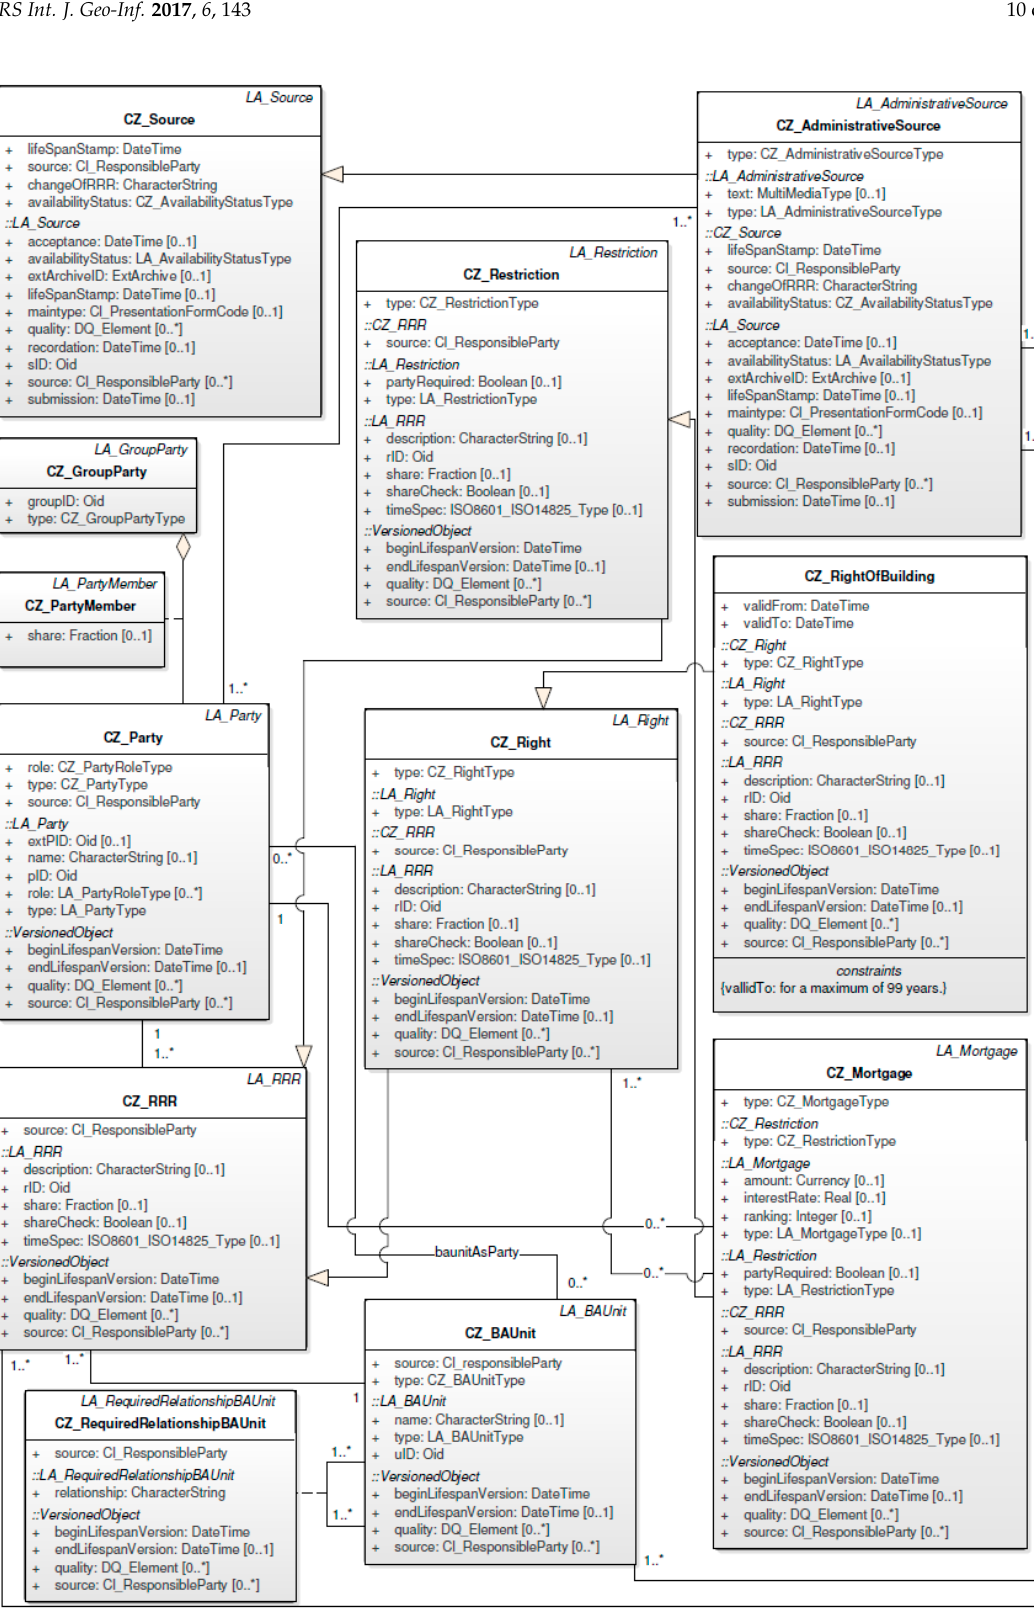
Figure 8. Overview of the legal component of the Czech country profile.